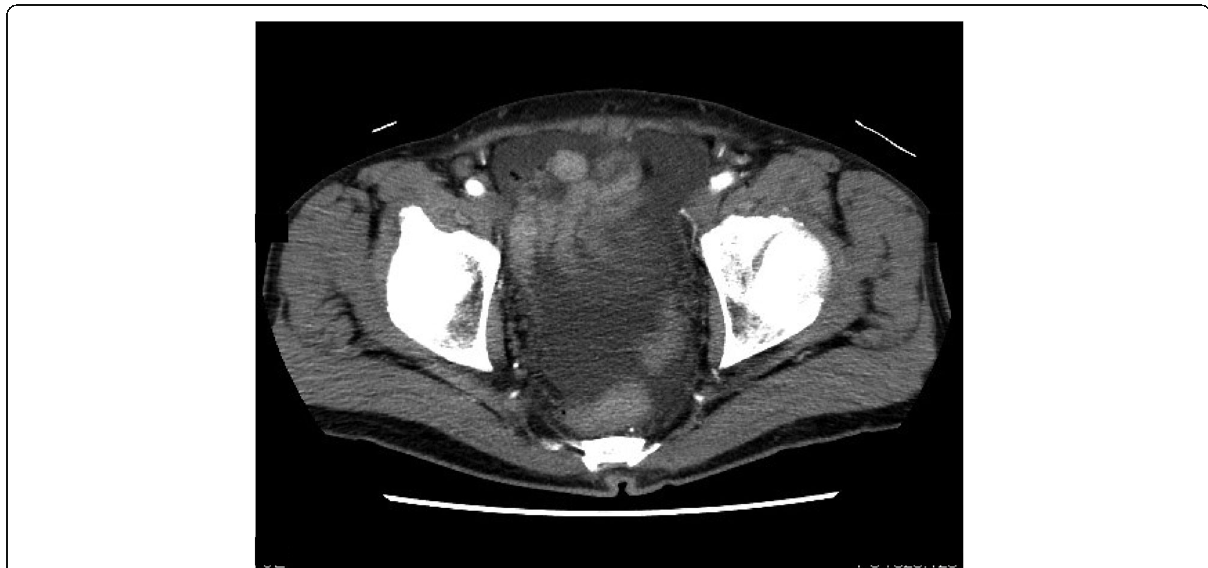
Fig. 1 Contrast-enhanced computed tomography image before staging laparoscopy showing pelvic